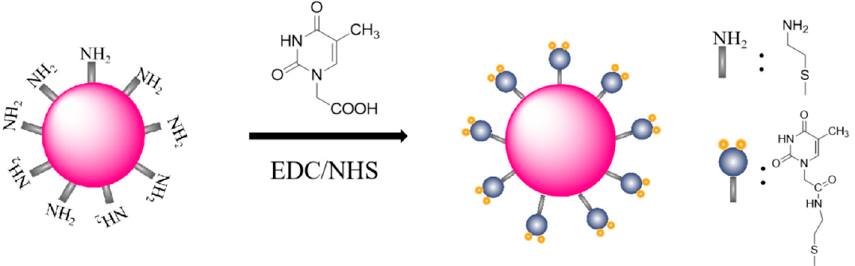
Figure 2. A schematic illustration of the fabrication of the thymine-modified gold nanoparticles (Au NPs/T).